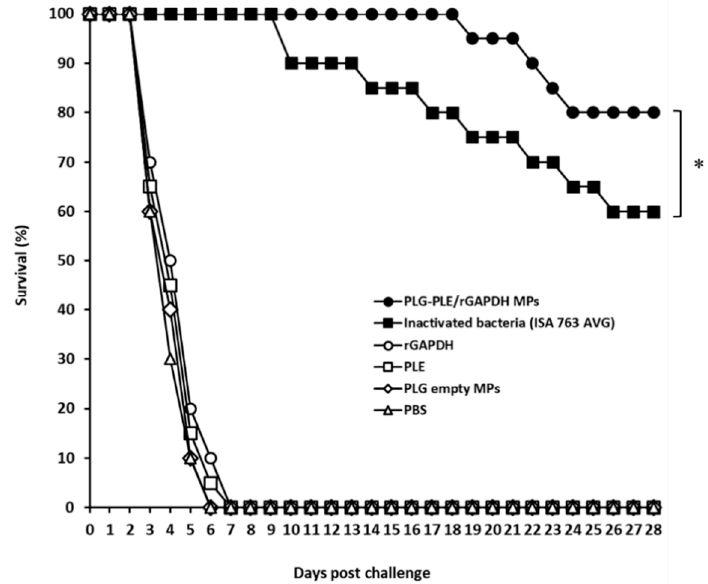
Figure 4. Grouper survival after a lethal peritoneal challenge of the highly virulent V. harveyi (Vh MML-1). Grouper were peritoneally vaccinated with a single shot of PLG-PLE/rGAPDH MPs ( ● ), a single shot of inactivated bacteria (ISA 763 AVG) ( ∎ ), a single shot of rGAPDH ( ○ ), a single shot of PLE ( □ ), a single shot of PLG empty MPs ( ◊ ), or a single shot of PBS ( ∆ ). Twelve weeks after peritoneal vaccination, six groups of 20 grouper each were infected with 6 × 10 6 CFU of V. harveyi (Vh MML-1) via the peritoneal route. Fish were observed for another 28 days and final survival rates of different groups were counted. (*) indicates p < 0.05 when comparing the PLG-PLE/rGAPDH MPs group to the inactivated bacteria (ISA 763 AVG) group.